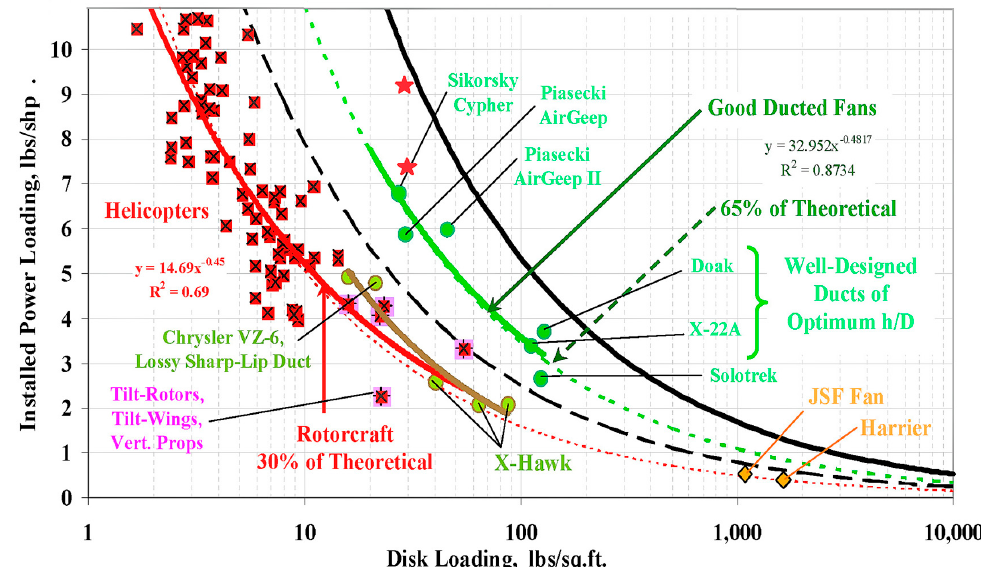
Figure 1. Disk loading vs. power loading for VTOL (vertical takeoff and landing) aircraft (original work by S. Paul Dev of D-STAR Engineering Corp., Shelton, CT, USA, reproduced with permission; verified and modified by the data from other sources [1,5]).